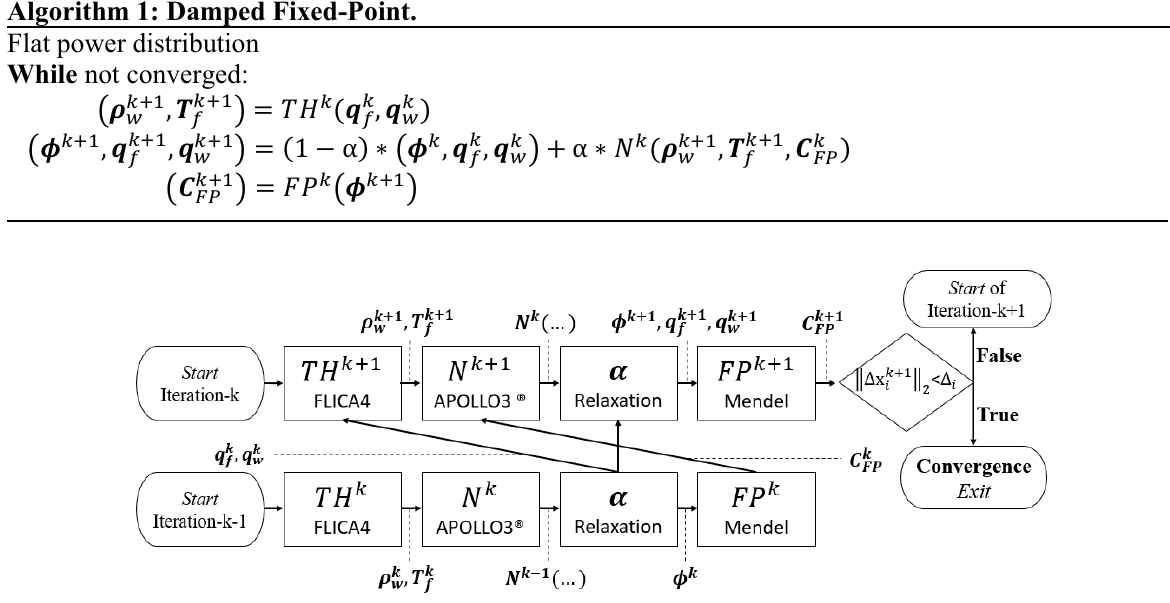
Figure 3: Flowchart of two consecutive iterations of Algorithm